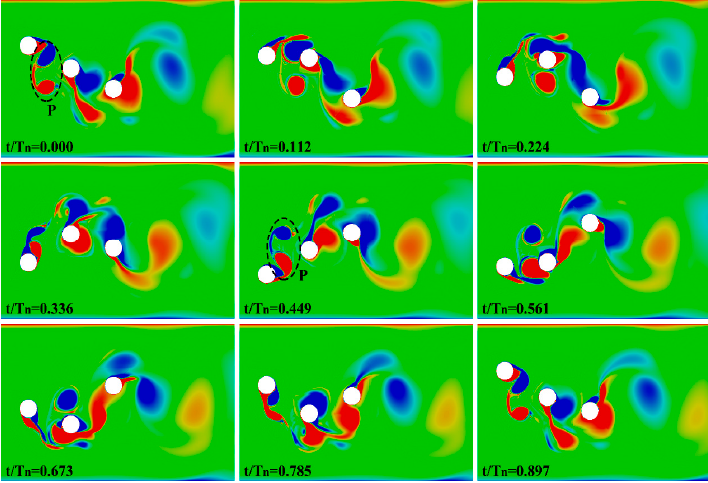
Figure 10. Near-wake structure of the three cylinders when Re = 60,000. Energies 2018 , 11 , x FOR PEER REVIEW